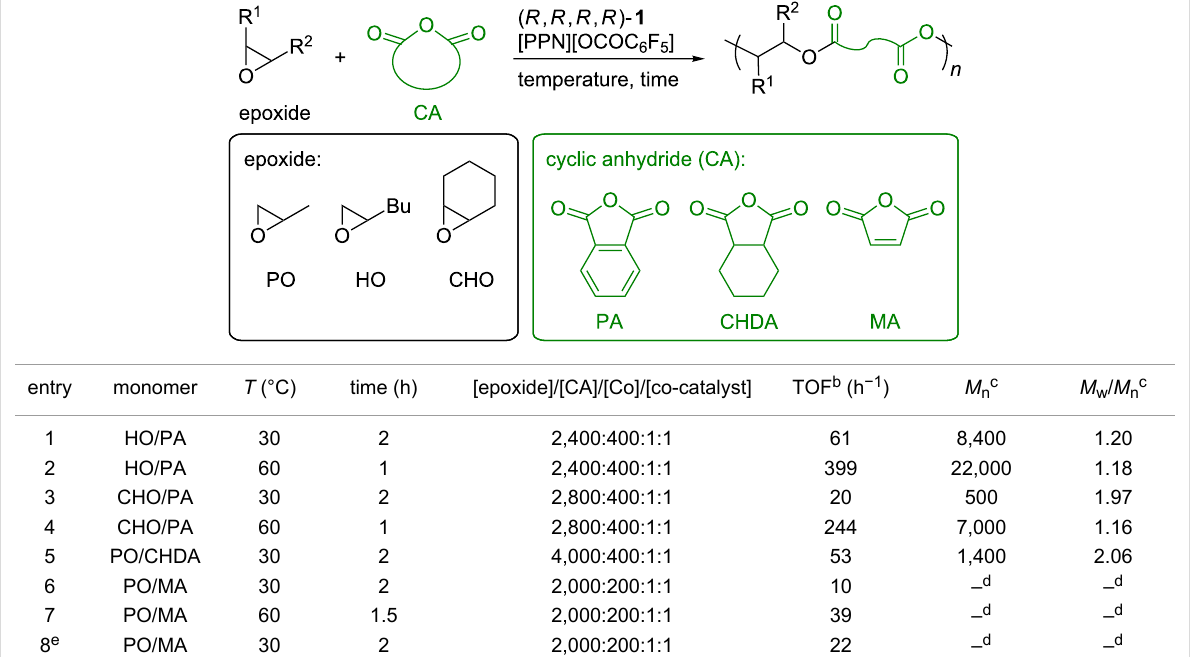
Table 2: Copolymerization of various epoxides and cyclic anhydrides. a